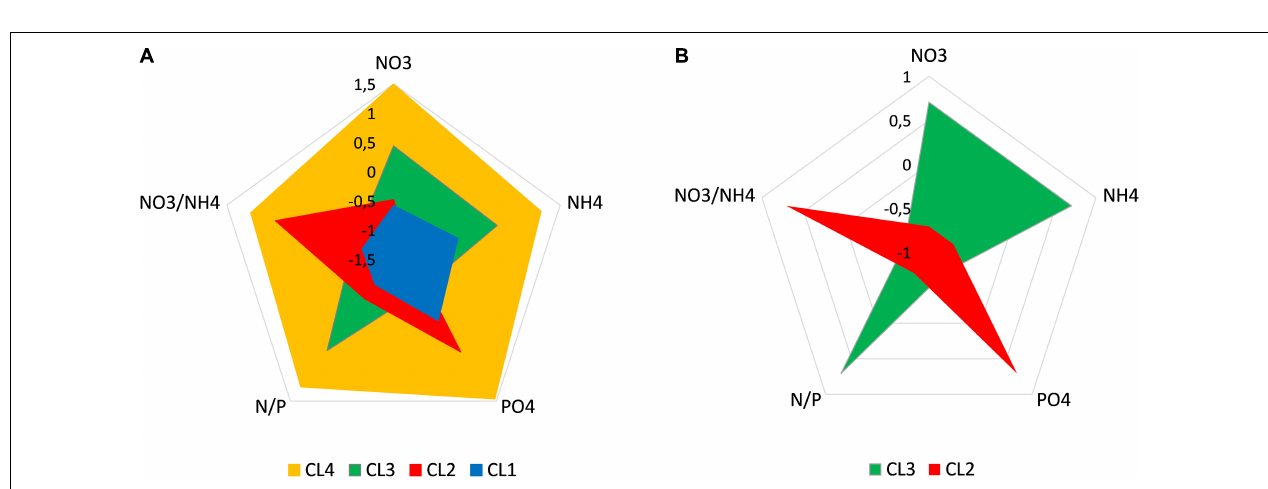
FIGURE 4 | Characterization of clusters by nutrient concentrations and their ratios (A) and better insight into the differences between clusters 2 and 3 (B) . Values are standardized as z-scores.